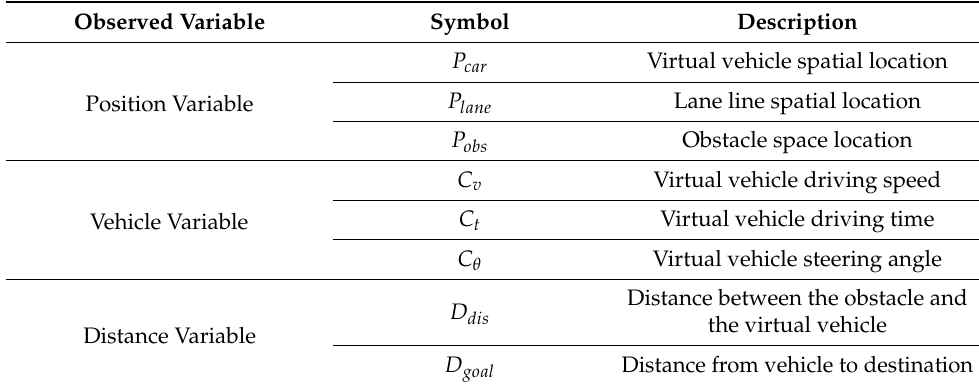
Table 1. List of state space